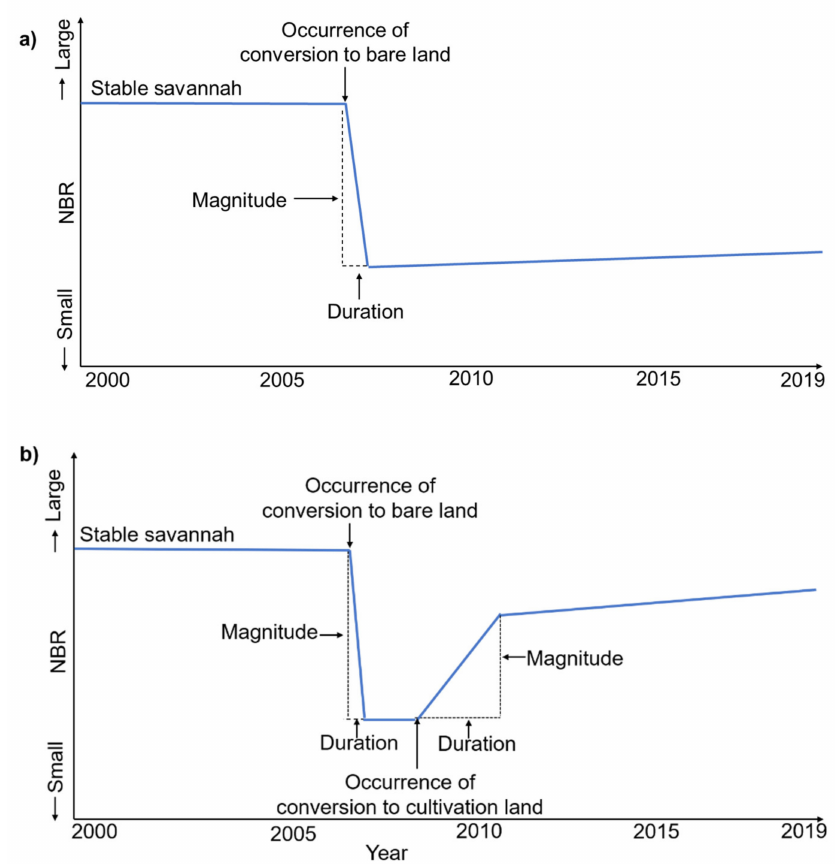
Figure 2. Conceptual models of the trajectories of the vegetation indicator ( NBR ) around the PA modified from Kennedy et al. [64]. The blue line represents the dynamic trajectory of the changed savannah area. The shape of the trajectory depends on the causes and progression of the change. ( a ) NBR trajectory for the conversion to bare land; and ( b ) NBR trajectory for the conversion to cultivated